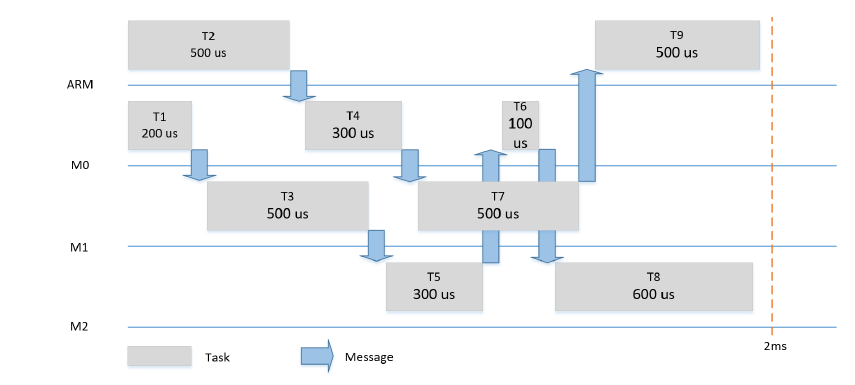
Figure 12. Scenario 2.